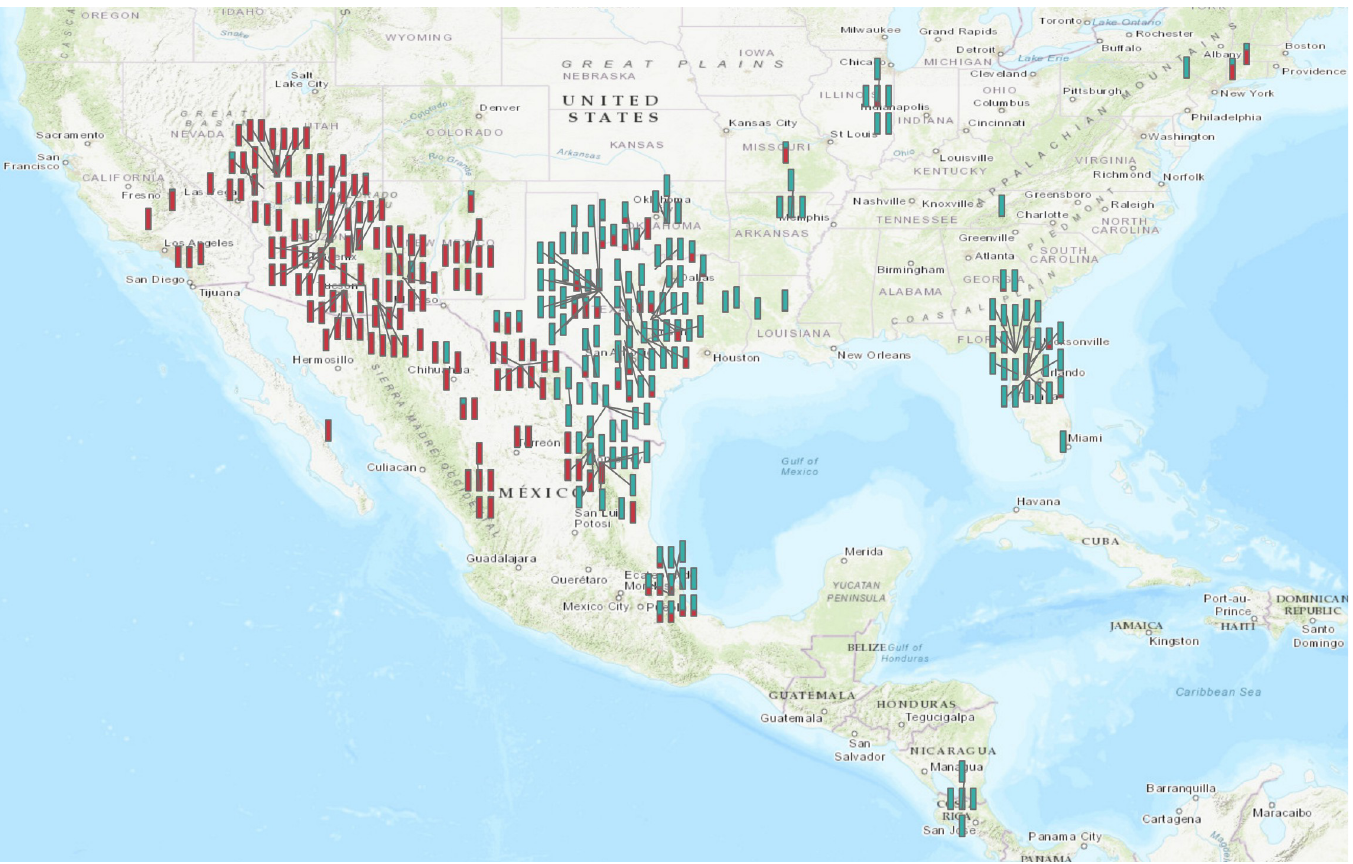
Fig 2. Graphical presentation of the phylogeographic results based on the membership estimates generated by the STRUCTURE program for each genotype. Bright cyan represents group 1 consisting of the southeastern US grape species. Moderate red represents group 2 consisting of the southwestern US grape species. Details of the accessions in each group are provided in supplementary S1